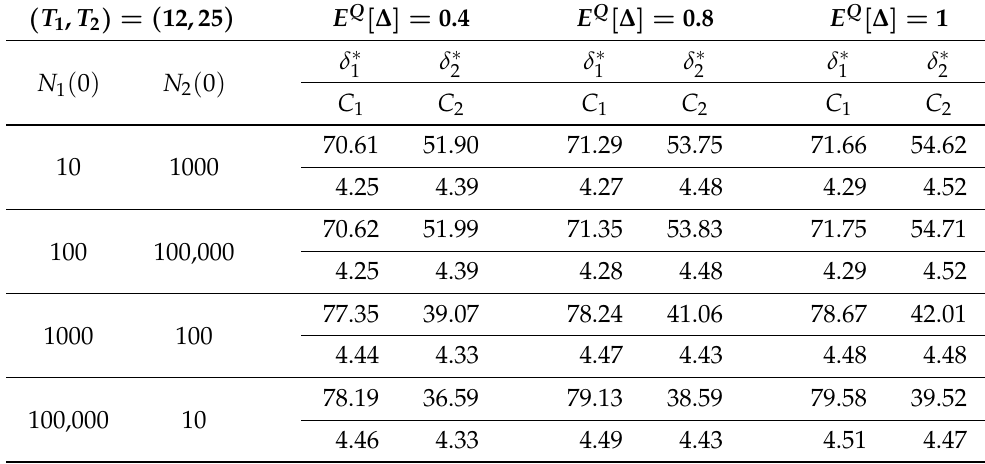
Table 7. Fair participation rates and certainty equivalent returns for Case 2 with ( T 1 , T 2 ) = ( 12,25 ) , different portfolio sizes with N 1 ( 0 ) (cid:54) = N 2 ( 0 ) and different values of E Q [ ∆ ] . All results are in percentage. ( T ) = ( 12, 25 ) E Q [ ∆ ] = 0.4 E Q [ ∆ ] = 0.8 E Q [ ∆ ] = 1 1 , T 2 δ ∗ N 1 ( 0 ) N 2 ( 0 )